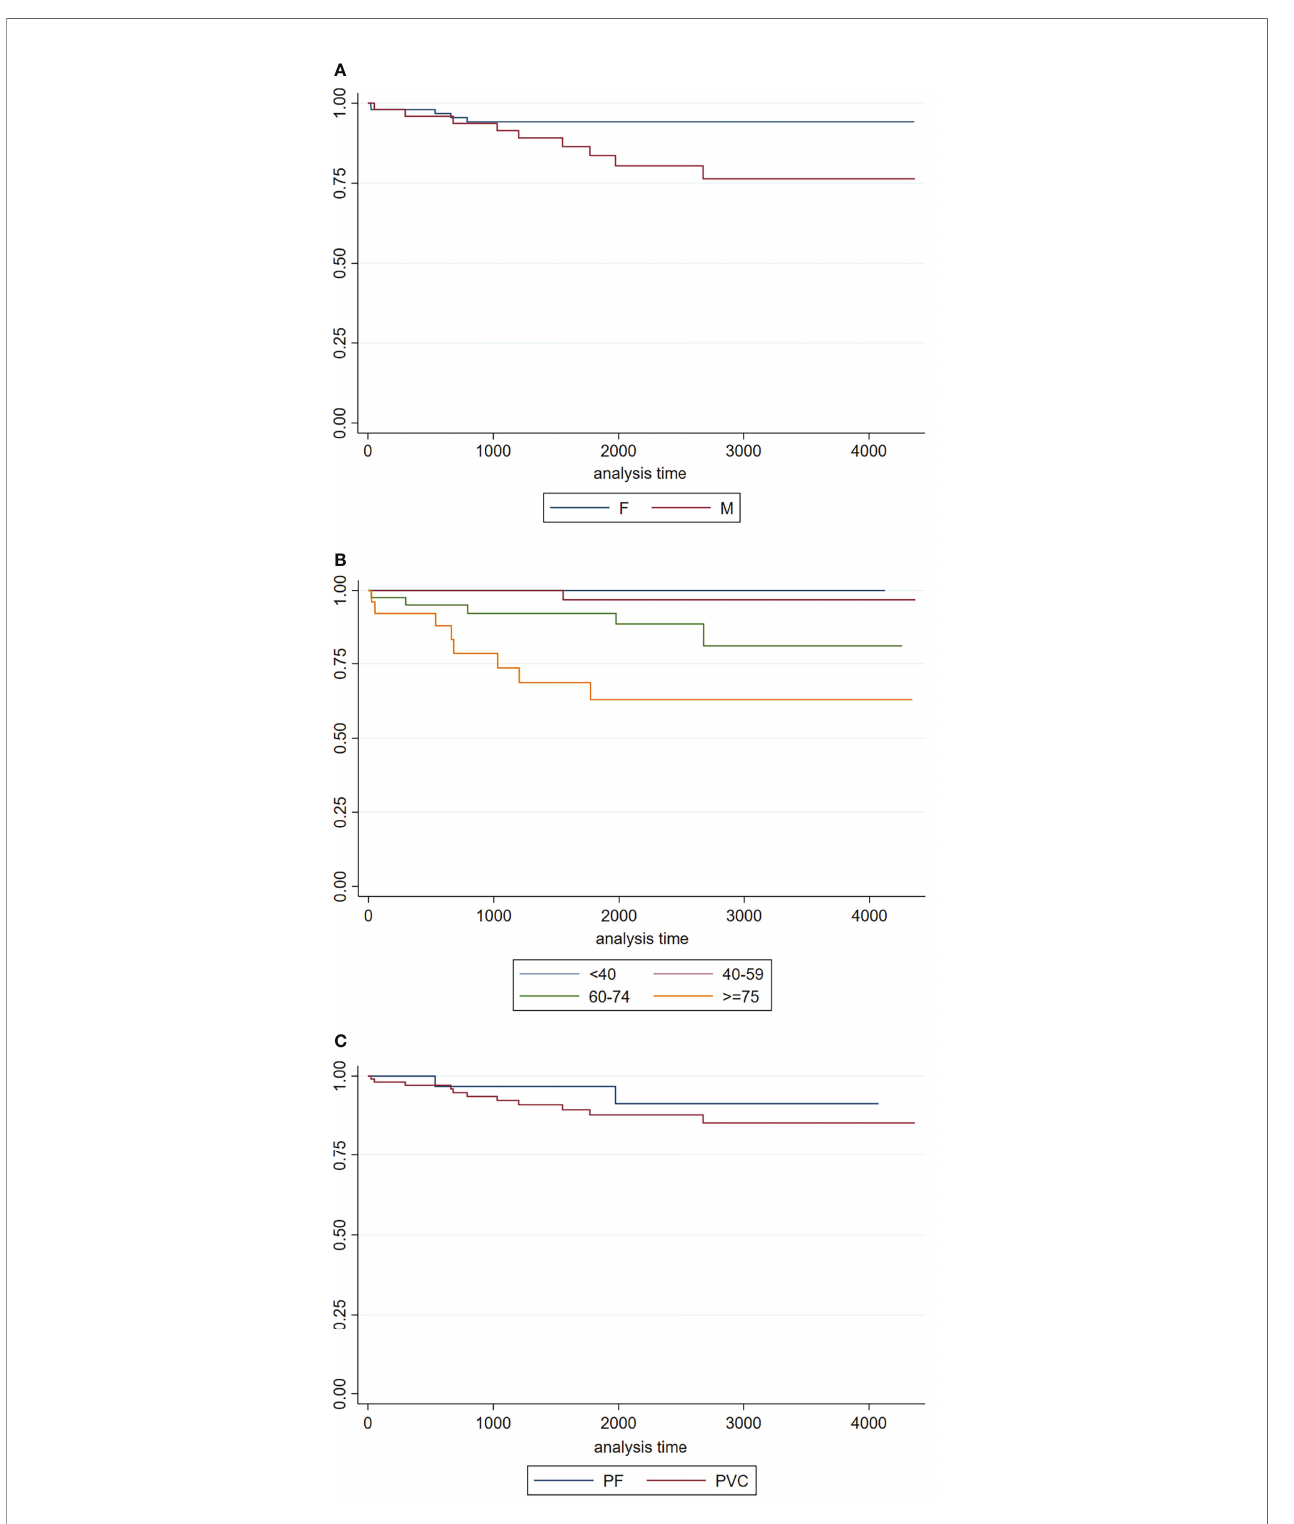
FIGURE 2 | (A) Kaplan – Meier survival curves by sex (female and male patients in continue and dotted lines, respectively); (B) Kaplan – Meier survival curves by age classes (under 40, between 40 and 59, between 60 and 74, over 75); (C) Kaplan – Meier survival curves by pemphigus variants (PF and